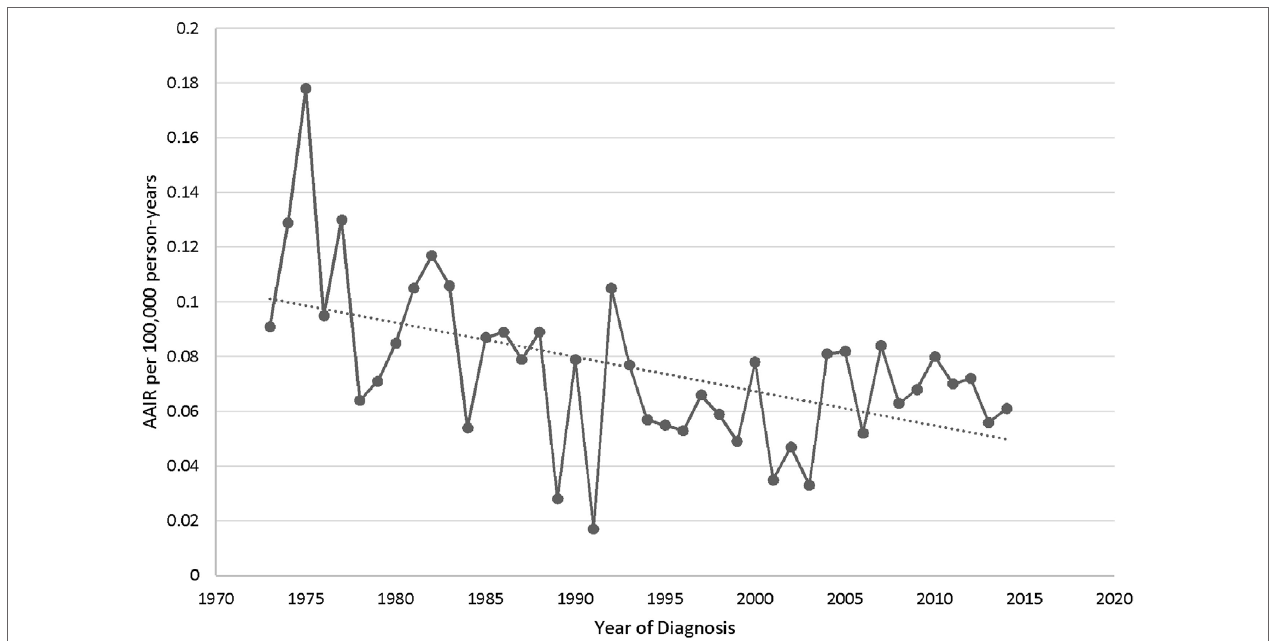
FigUre 2 | Trend in age-adjusted incidence rates of primary salivary gland tumors of lung in the United States.